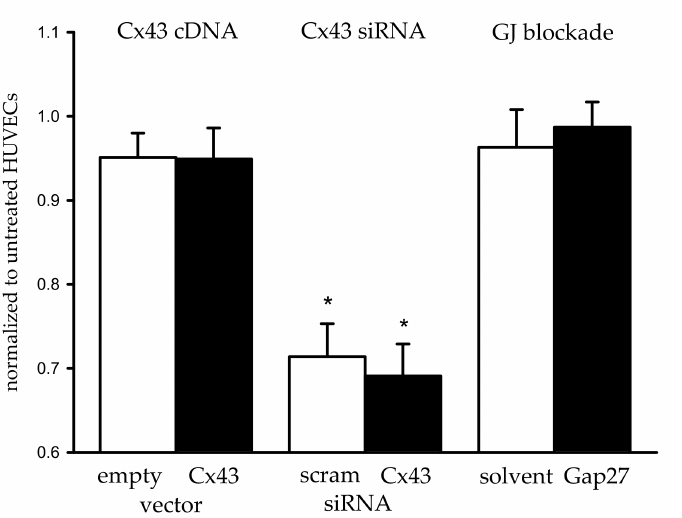
Figure 2. Proliferation assessed by BrdU incorporation remained unaltered by modulation of Cx43. The absorption values after BrdU incorporation are normalized to paired sample values obtained in non-treated HUVECs. The treatment groups are shown in black, and the respective controls are shown as white bars. Proliferation was not different after transfection with Cx43 cDNA ( n = 36), Cx43 siRNA ( n = 33), or Gap27 ( n = 54) compared to the respective sham treatment group. Treatment with siRNA decreased proliferation markedly but to a similar degree in the scrambled (scram) and Cx43 siRNA group. * p < 0.05 vs. non-treated HUVECs (paired t -test), differences between treatment and sham-treated groups were not detected (paired t